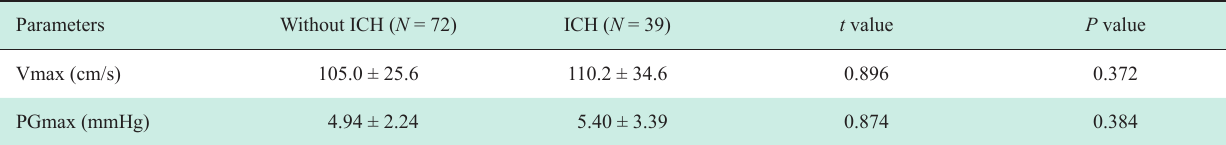
Table 6 Comparison of the diameter and hemodynamic parameters at the stenosis site between groups with and without intracranial hypertension (ICH) Parameters Without ICH ( N =